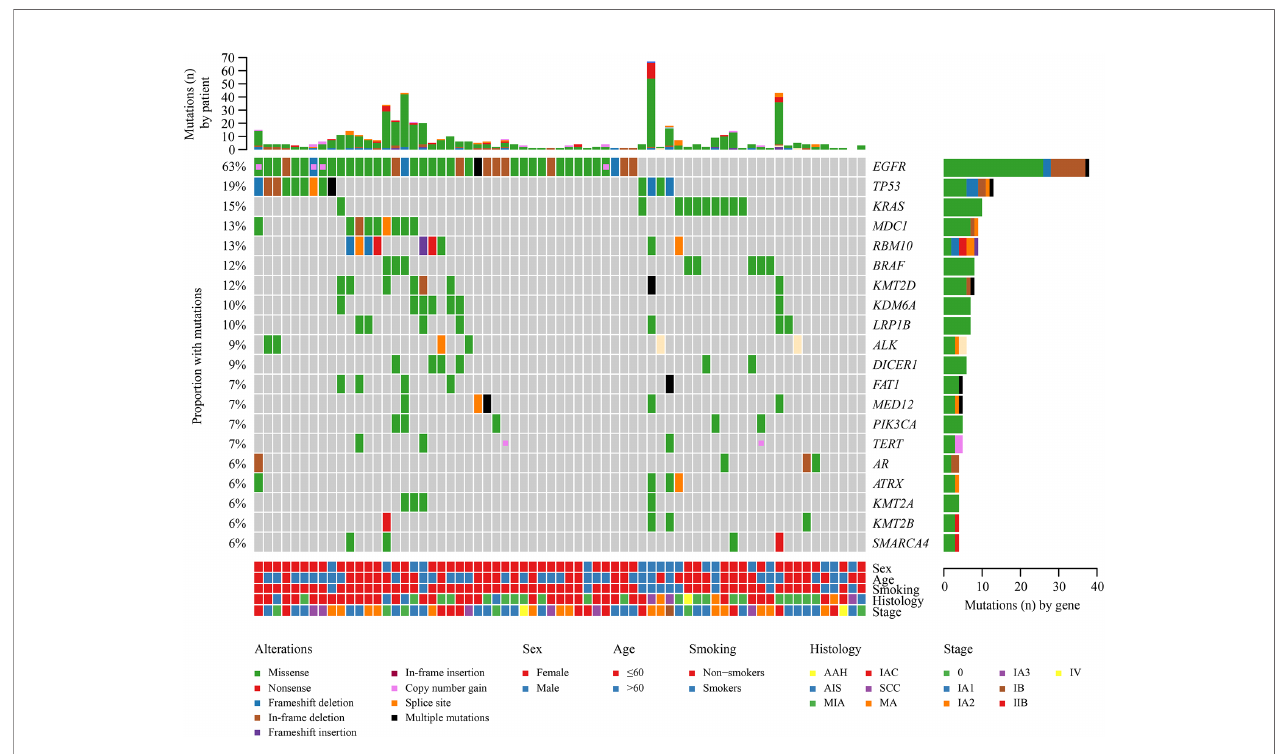
FIGURE 2 | Landscape of genomic alterations in 67 multiple lung cancer samples. Genetic mutations were identi fi ed by targeted next-generation sequencing in the tumor tissues of the patients. The upper panel shows the numbers of non-synonymous single-nucleotide variants, small insertions or deletions, and copy number variants in each tumor. The heat map below shows the genes with somatic mutations sorted according to the mutation frequency. Clinical features are annotated in the lower